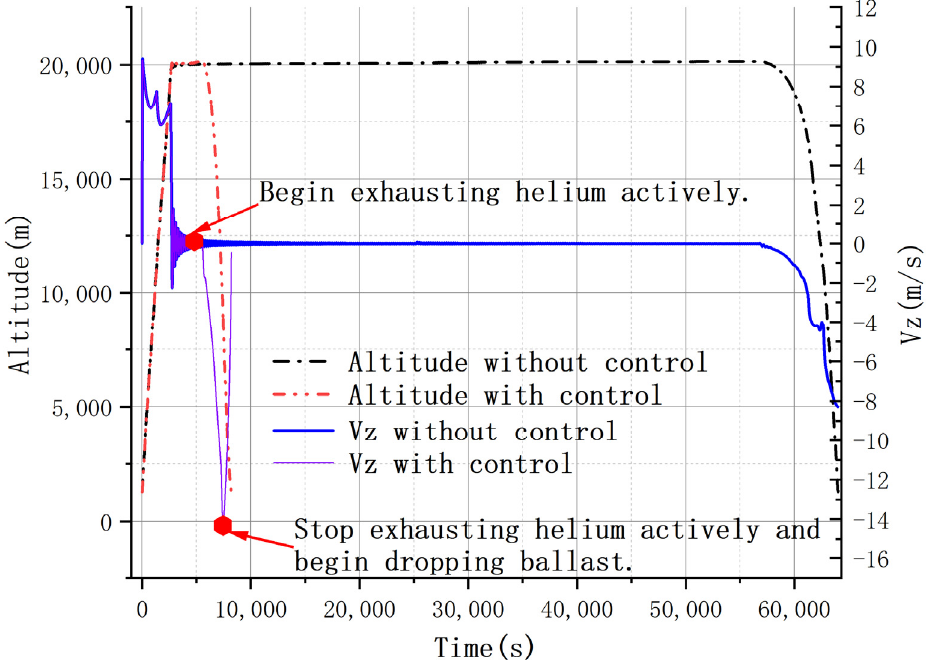
Figure 17. Simulation results of Mission B: balloon system’s change in vertical speed vs. time and change in altitude vs. time while the control strategies are applied (or not).